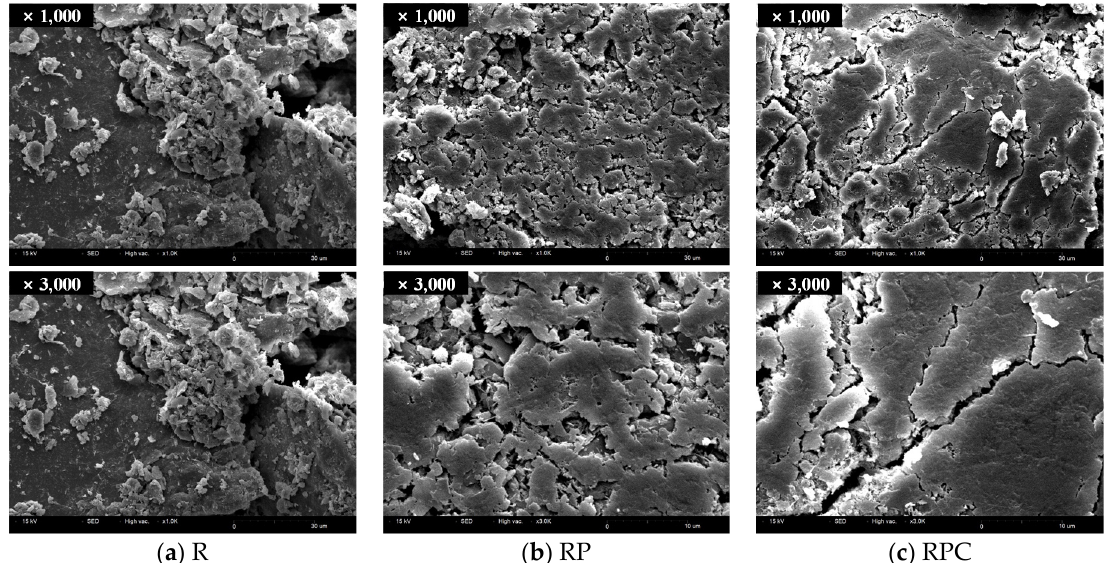
Figure 10. Scanning electron microscopy micrographs of specimens of 7 days age.